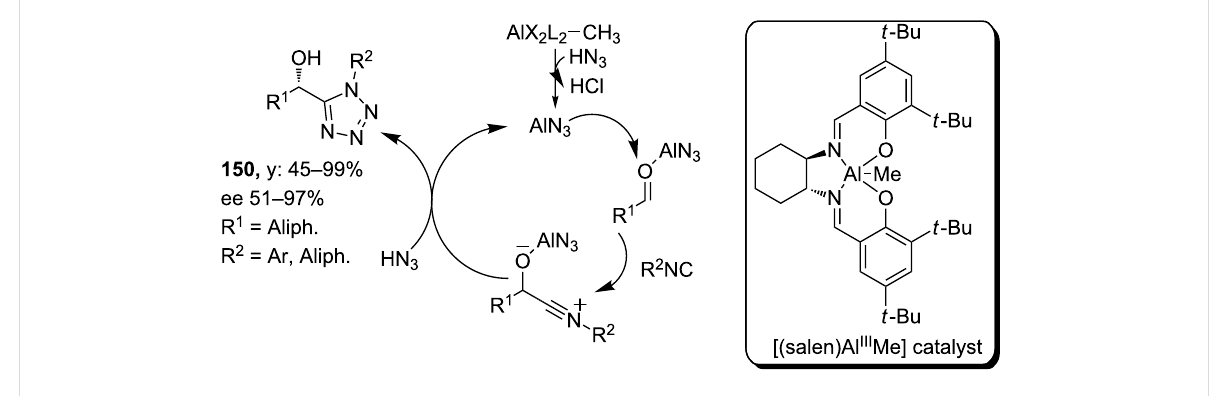
Scheme 46: Catalytic cycle of the enantioselective Passerini reaction towards tetrazole-based